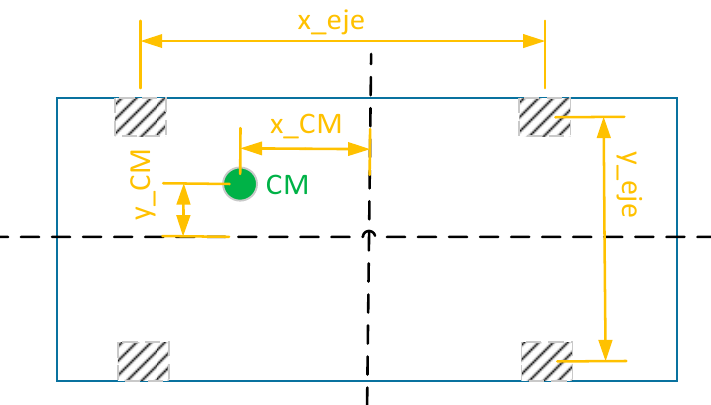
Figure 12. AGV top view. Position of the resulting center of mass.